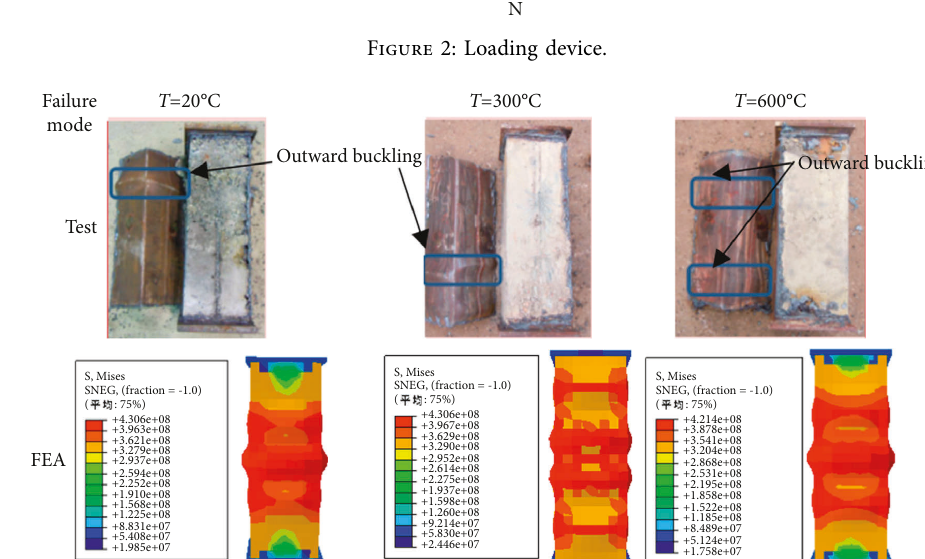
Figure 2: Loading device.